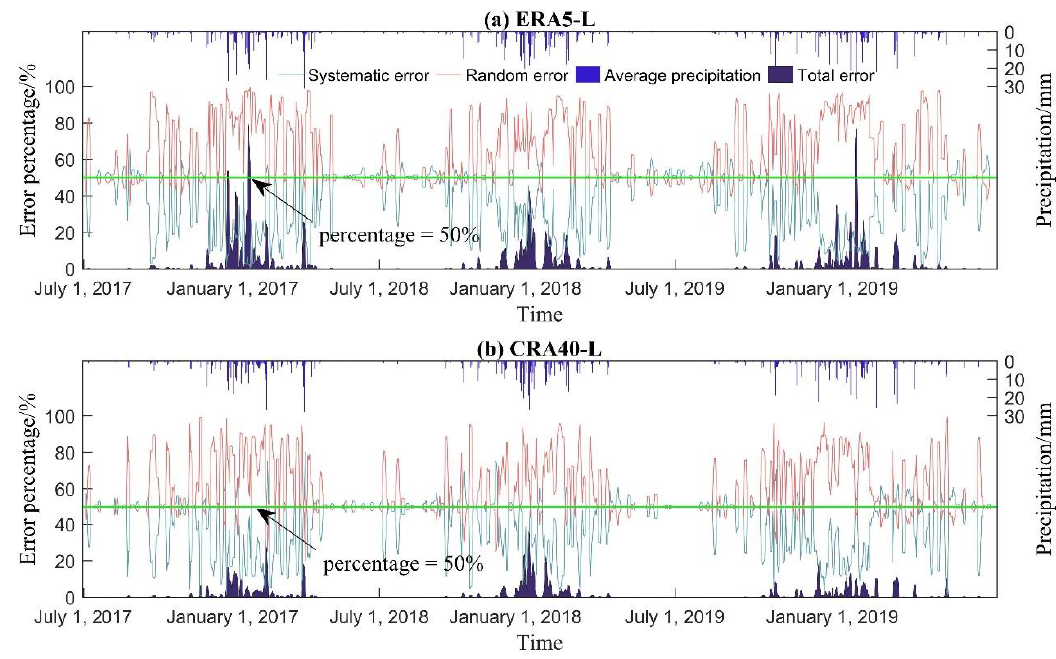
Figure 5. ( a , b ) Proportions of systematic and random errors over time.